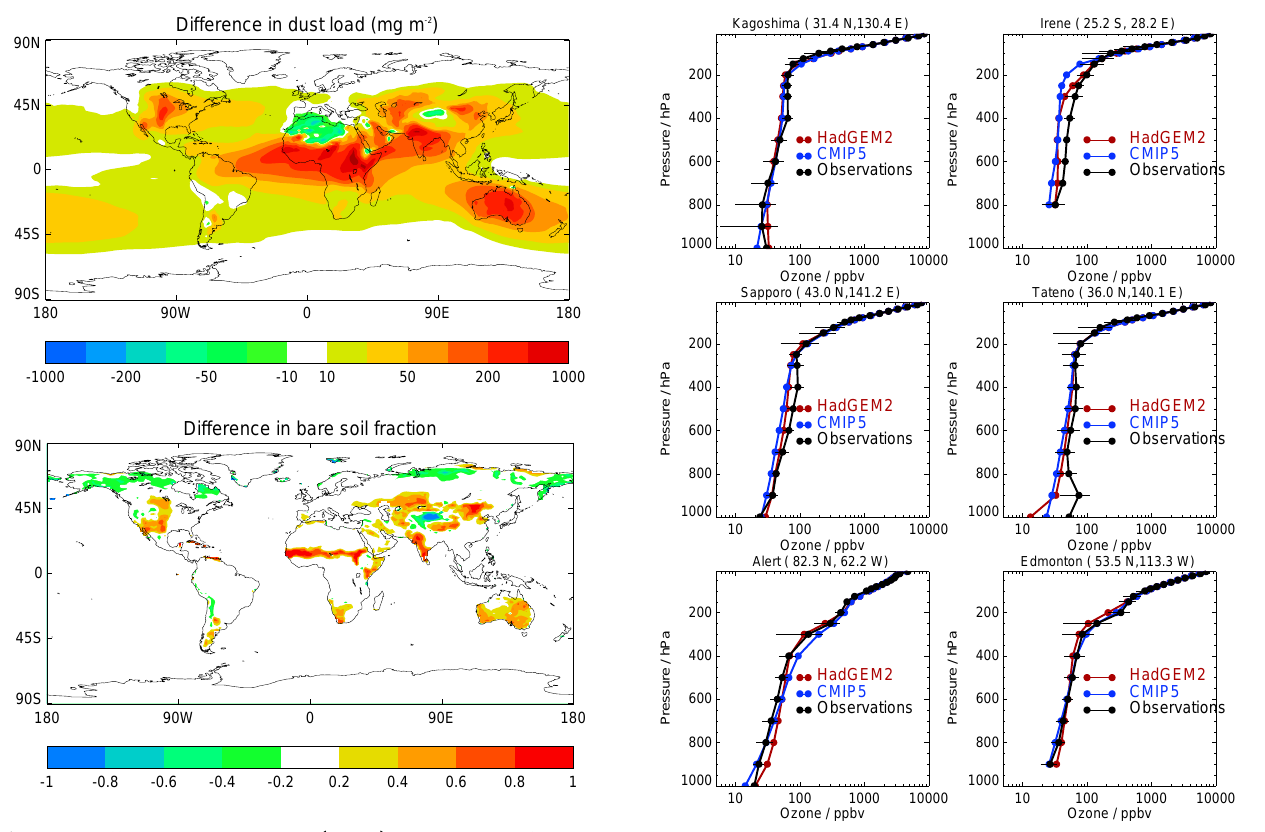
Fig. 12. Comparison of modelled July vertical ozone profiles with climatological observations (black) from Logan 1999), interactive chemistry (red) and the CMIP5 ozone concentrations